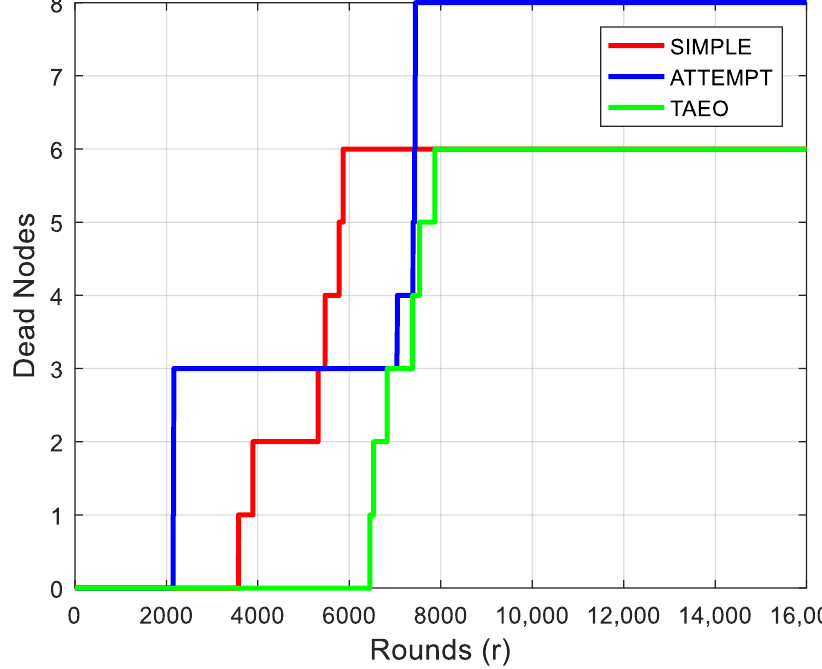
Figure 3. Evaluation of Network Lifetime & Stability Period.